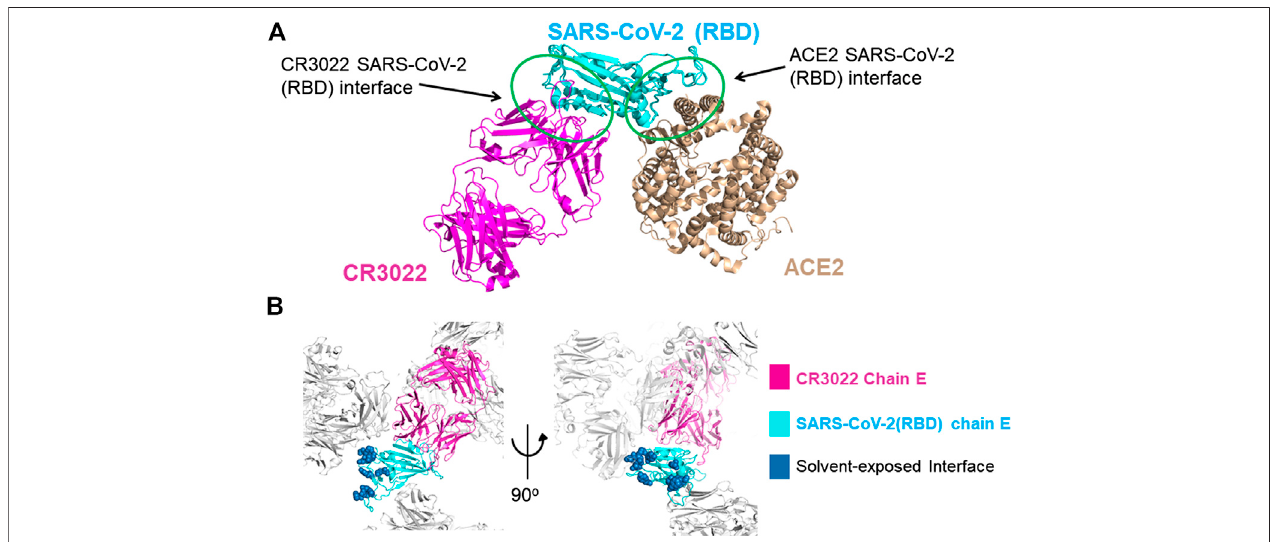
FIGURE 1 | (A) Superimposition of the X-ray structures of the SARS-CoV-2-RBD CR3022 (PDB 6W41) and SARS-CoV-2-RBD:ACE2 (PDB 6MOJ) complexes. The antibody and the human receptor use two distinct non-overlapping surfaces to interact with the virus receptor binding domain. (B) zoom-in on the lattice reconstruction of the SARS-CoV-2-RBD:CR3022 complex from the PDB 6ZLR. The Chain E of the complex in the ASU is colored, the ACE2 binding site on the RBD is shown in dark blue, it highlights that the entire binding site is solvent accessible on chain E.